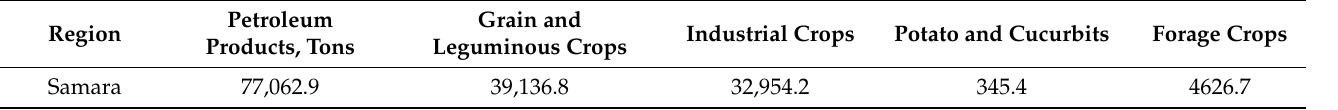
Table 6. Petroleum products used in cultivation of agricultural crops by areas of the Samara region in